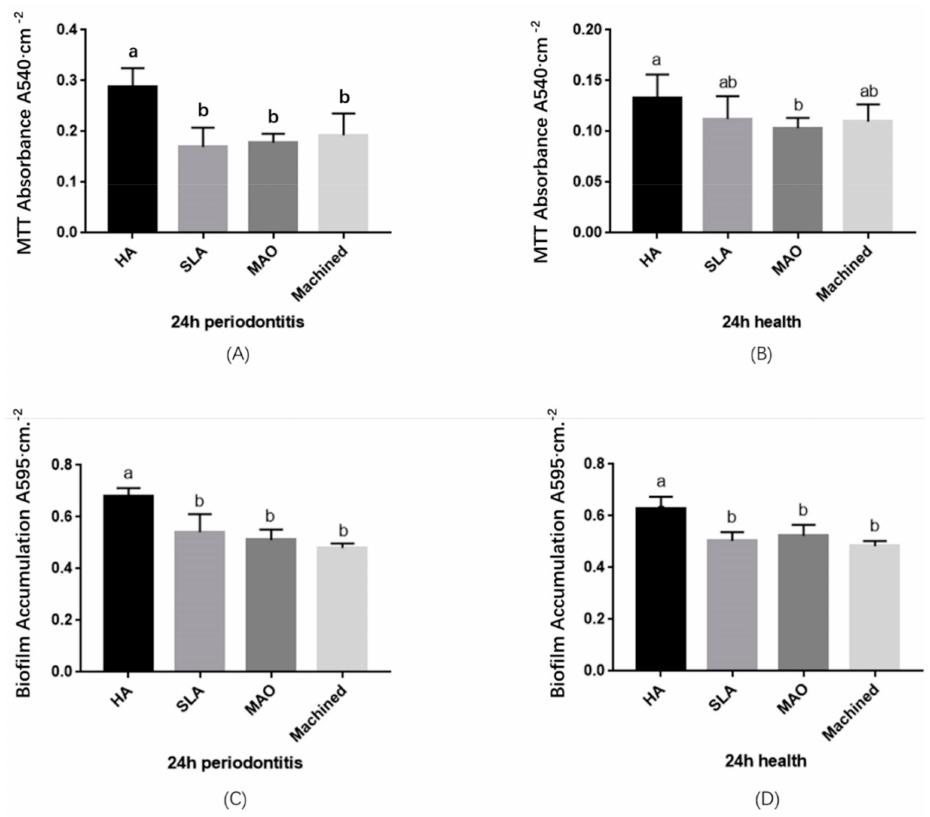
Figure 3. Biomass accumulation and metabolic activity of saliva-derived biofilms (periodontitis and health) on titanium discs. ( A , B ) The metabolic activity of saliva-derived biofilms (n = 6); and ( C , D ) the biomass accumulation of saliva-derived biofilms on titanium discs (n = 6). Significant di ff erences between bars are marked with the letters a and b ( p <